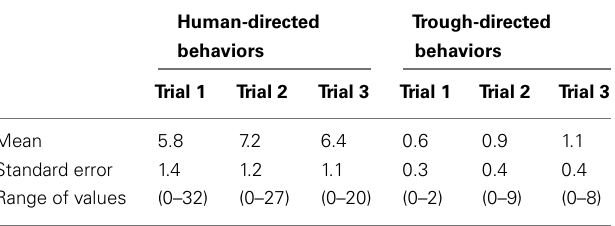
trough-directed behaviors across trials for horses that failed to open the chest ( N =